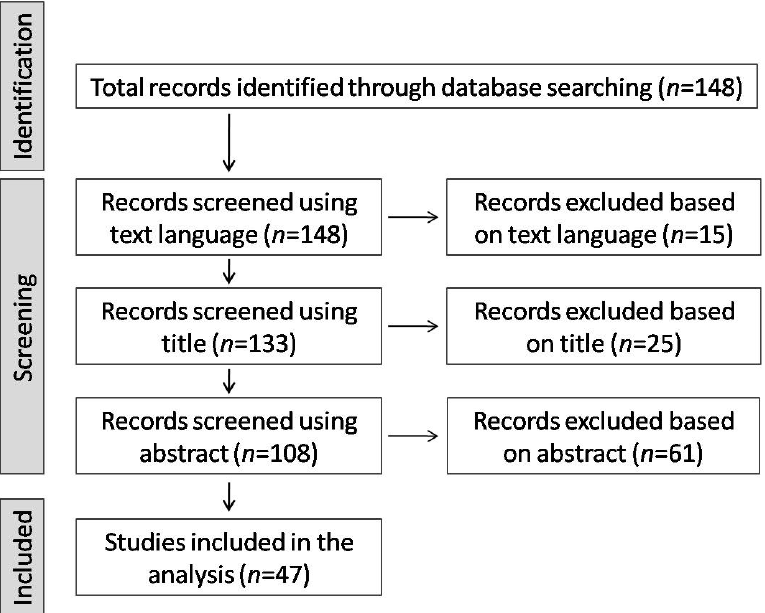
Figure 1. The study selection diagram showing the flow of documents through the literature re- view.